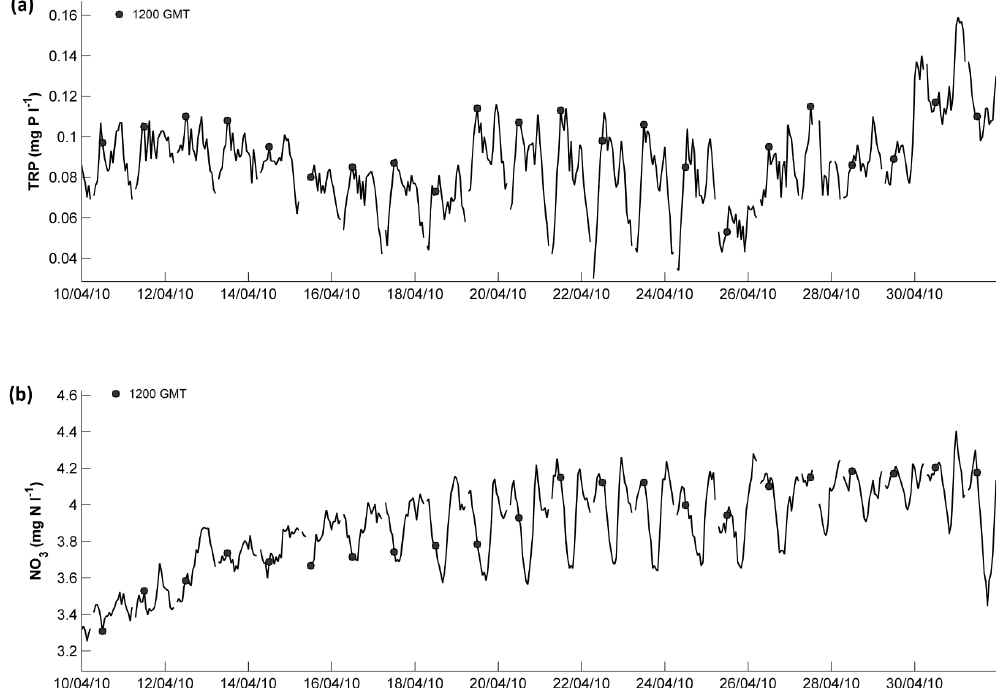
Figure 8 2 Fig. 8. Two-peak diurnal patterns within the observed streamwater (a) TRP and (b) NO 3 concentrations in the River Enborne.